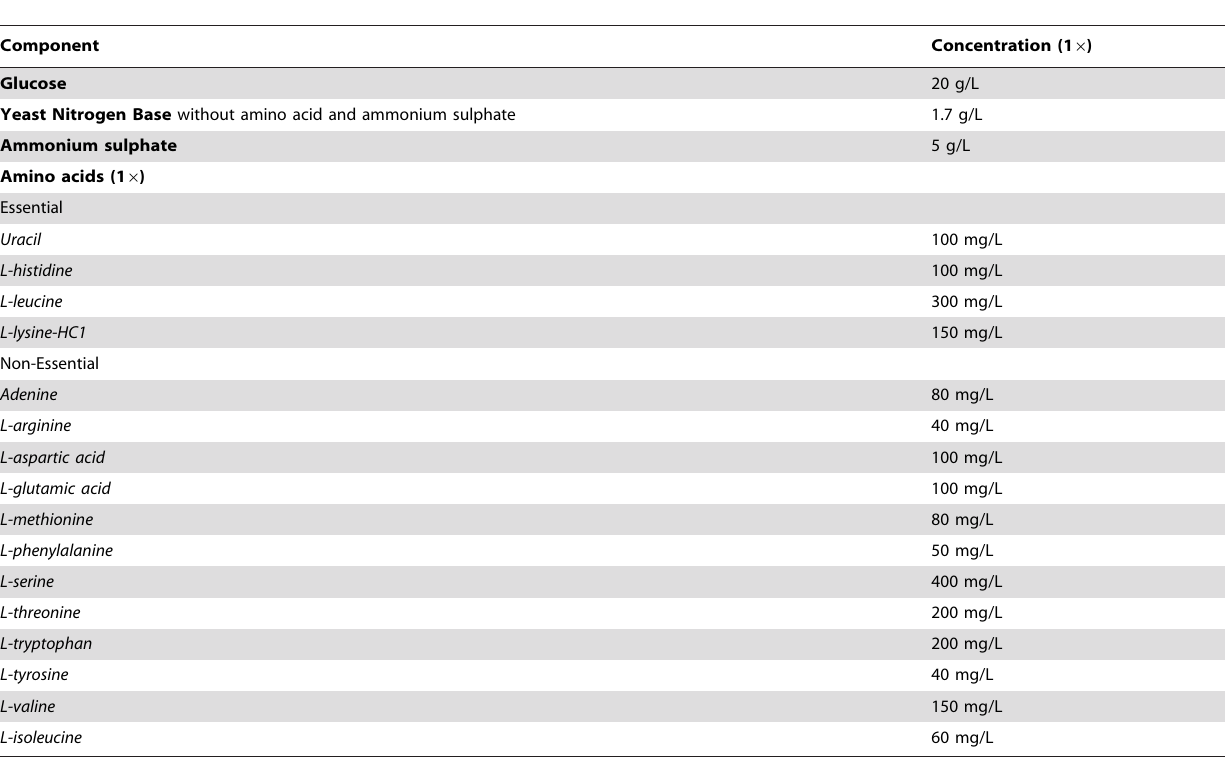
Table 1. Composition of synthetic defined (SD) medium used for yeast CLS analysis.